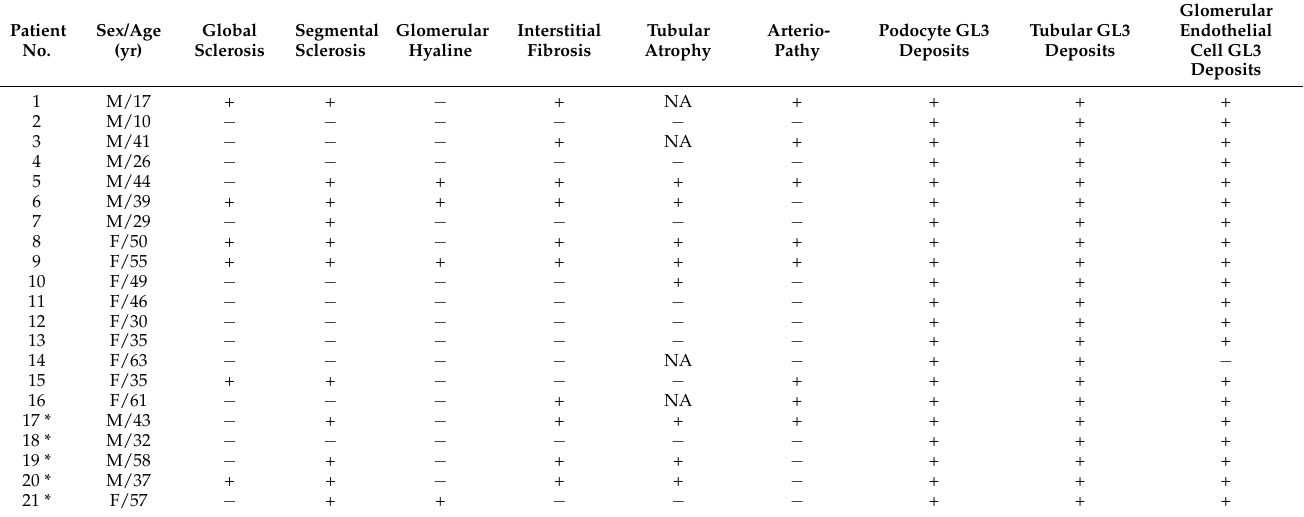
Table 4. Light microscopy and electron microscopy findings of the renal biopsy specimens.